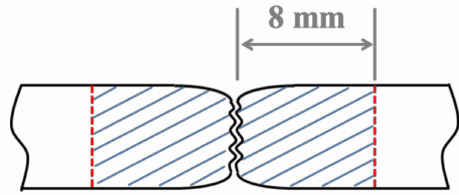
Figure 1. Sampling location of 8 mm long sample for hydrogen analysis.